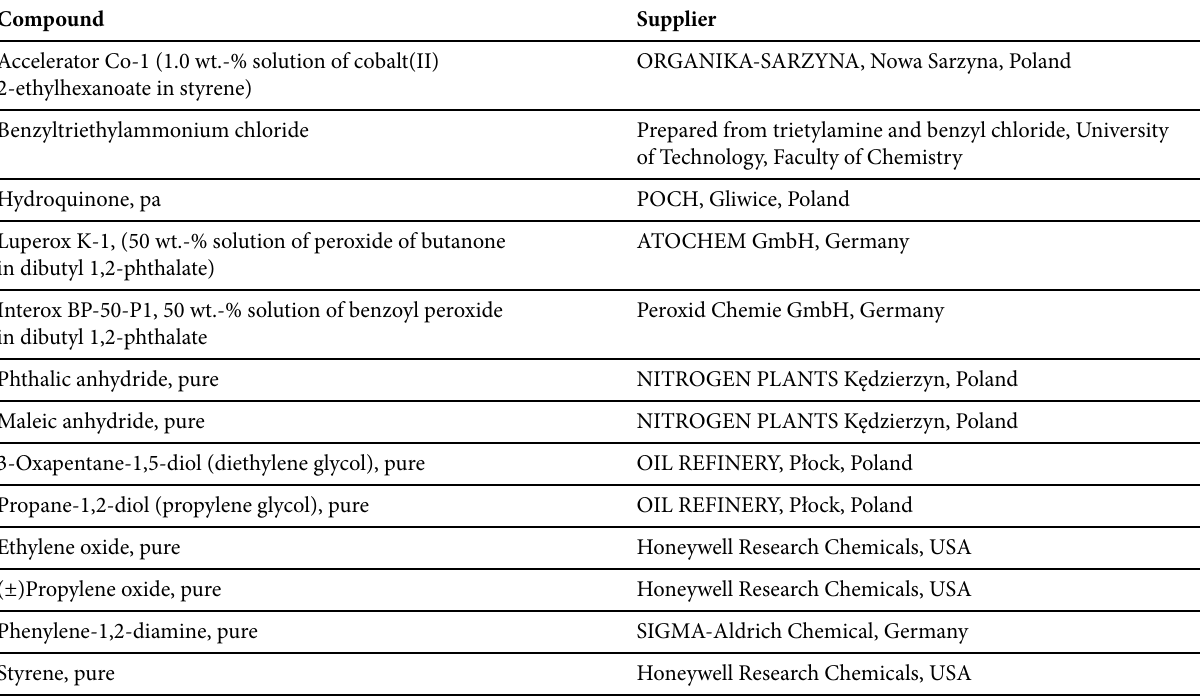
Table 1. Compounds Used and Their